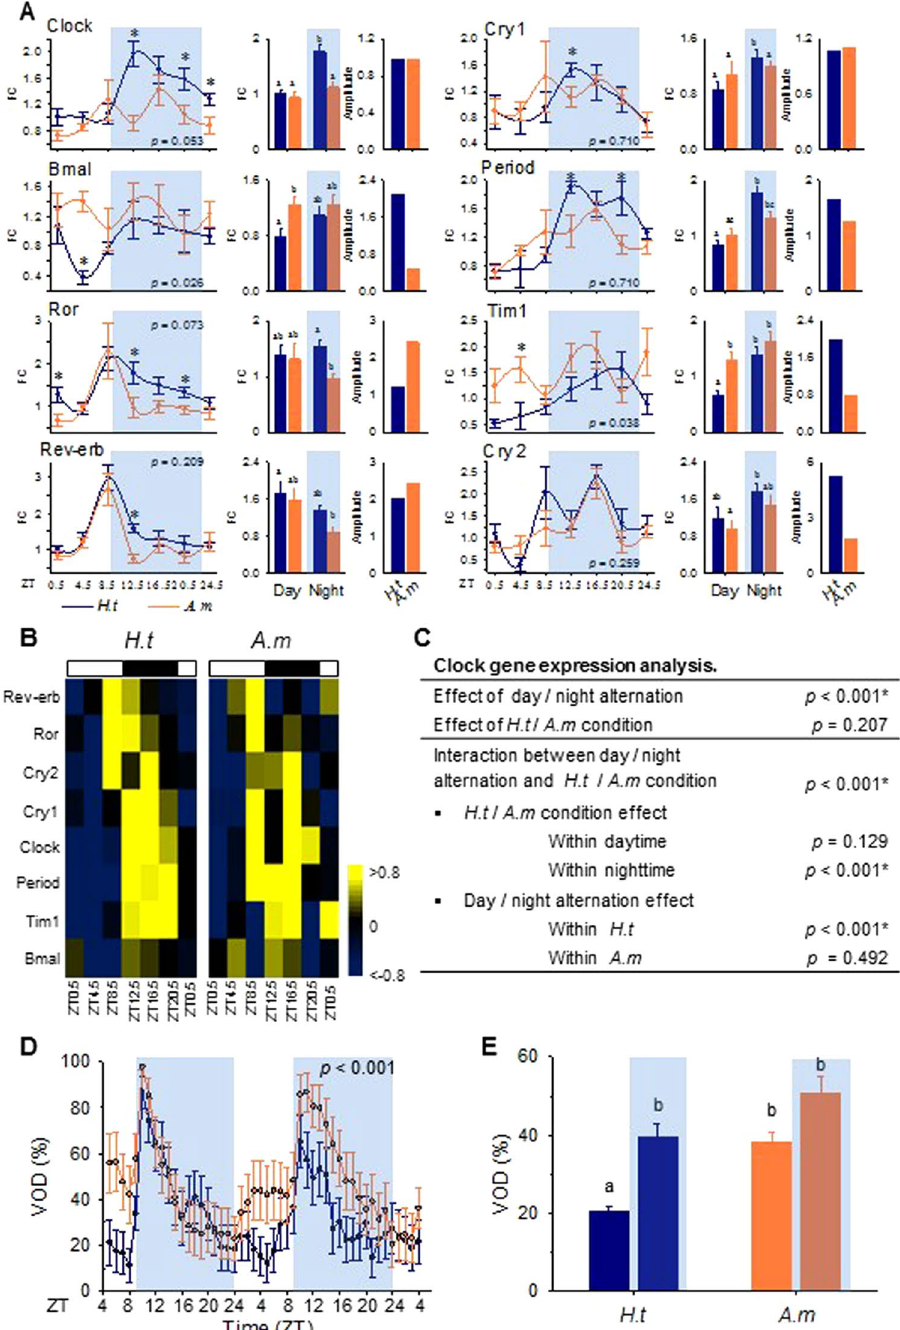
Figure 2. A nocturnal pattern of circadian core clock gene expression and valve activity behavior modeled by A. minutum exposure. ( A ) Real-time qPCR analysis of circadian clock gene expression expressed in fold change (FC, mean ± SE, n = 5–6) for H.t and A.m . Gray areas correspond to nighttime. The p -values show different levels of expression over 28 hr between H.t and A.m , while stars indicate the different levels of expression at each time point. The first histograms show the mean levels of gene expression (FC). Different letters correspond to significant differences ( p < 0.05). The second histograms show amplitudes of clock gene expression in H.t and A.m . ( B ) Heat maps of clock gene expression over 28 hr, organized by phase for H.t and A.m (RT-qPCR). ( C ) Two-way ANOVA testing the effect of day/night and H.t / A.m conditions on overall clock gene expression. ( D ) Mean hourly valve opening duration (VOD, %; mean ± SE; n = 16 per condition) of H.t (blue) and A.m (orange) oysters during the two days of sampling. The p -value corresponds to the difference in the mean VOD between the two conditions. ( E ) Mean VOD during daytime and nighttime for each condition. Different letters indicate significant differences ( p <